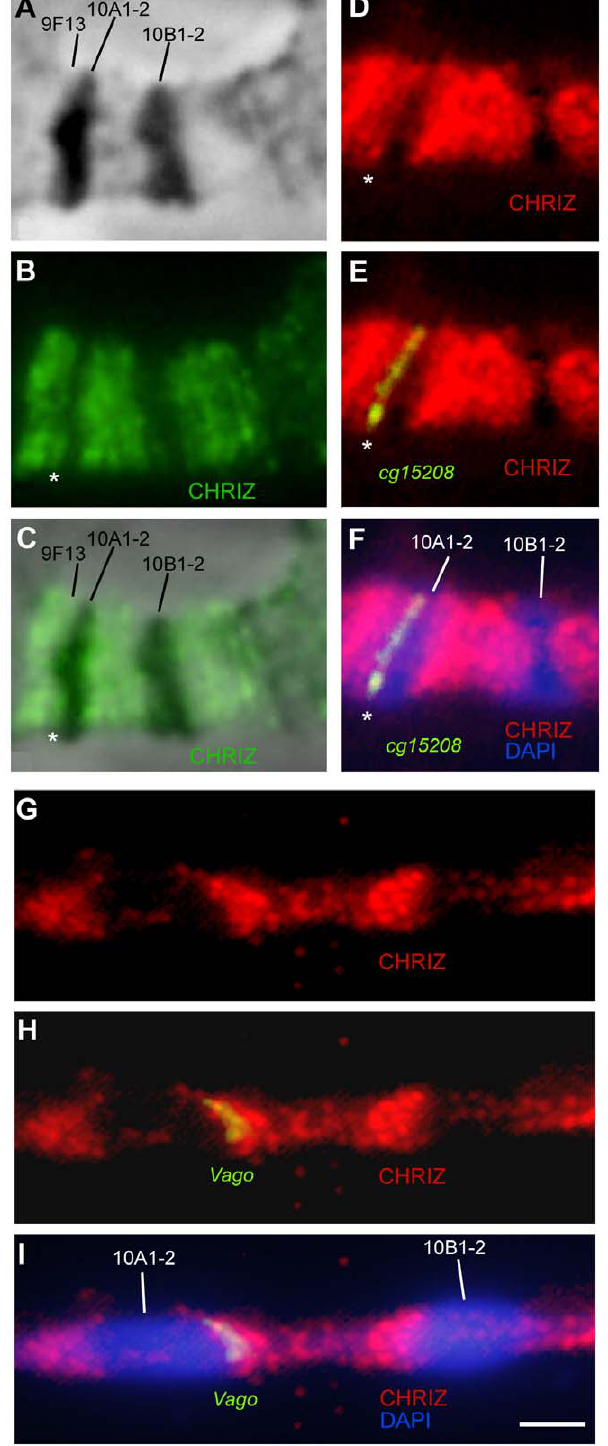
Figure 4. Colocalization of DNA probes limiting the 10A1–2 band with the Chriz/CHRO protein. Localization of the Chriz protein in the 10A–B region ( A–C ); the bands in the region under phase contrast ( A ), the Chriz/CHRO protein, asterisk points to the interband 9F13/10A1–2 B), match of Chriz/CHRO location and phase contrast ( c ), colocalization of the DNA probe CG15208, limiting distal side of the band 10A1–2 and Chriz/CHRO protein ( D–F ); colocalization of the DNA